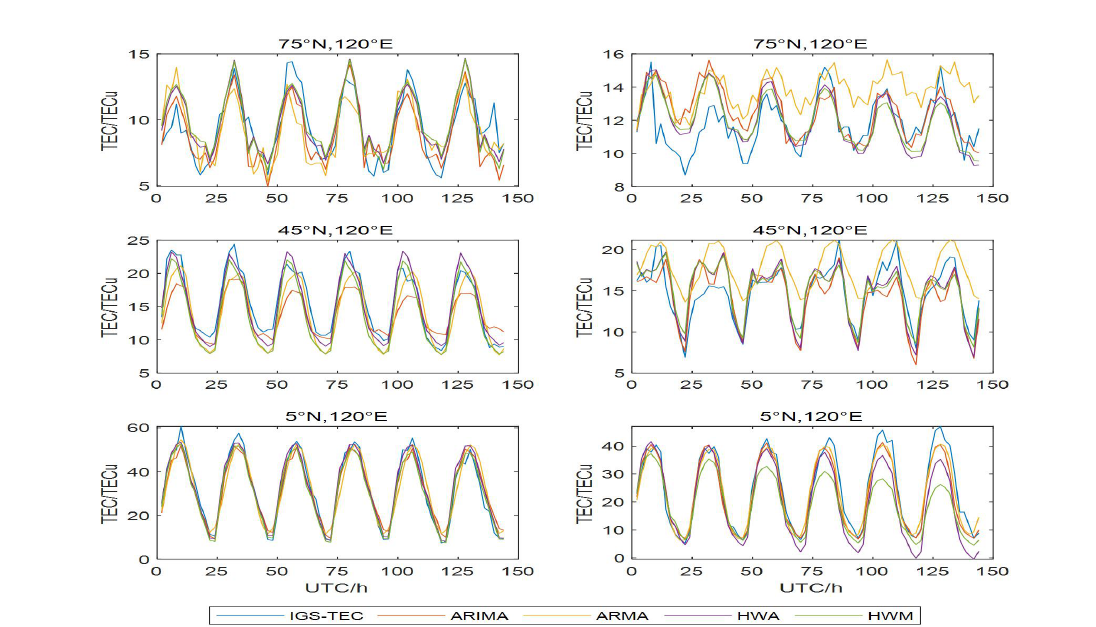
Figure 1. Prediction results of ionospheric TEC in different grid at quiet and active period Figure 1 shows the comparison between the prediction results holt-winter addition model, and the green line (HWM) in quiet period and active period of different latitudes and the represents the prediction value of holt-winter multiplication actual observed data. In the figure, the x-coordinate represents model. It can be seen from figure 1 that in the quiet and active the prediction calendar element (one calendar element every 2 ionospheric periods, ARIMA model, ARMA model, holt-winter hours), and the y-coordinate represents the ionospheric TEC addition model and multiplication model can well reflect the value (unit: TECu).The blue line (IGS-TEC) represents the temporal and spatial variation characteristics of ionospheric actual observation value provided by IGS center, the red line TEC at high, medium and low levels. Compared with the (ARIMA) represents the prediction value of ARIMA model, the prediction effect of the quiet period and the active period, the yellow line (ARMA) represents the prediction value of ARMA prediction effect of the quiet period is better. model, the purple line (HWA) represents the prediction value of